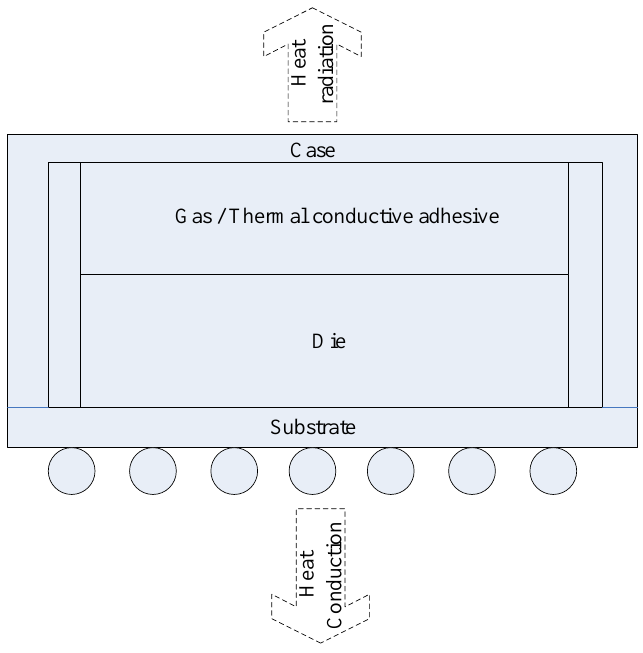
Figure 7. SiP internal thermal resistance model.